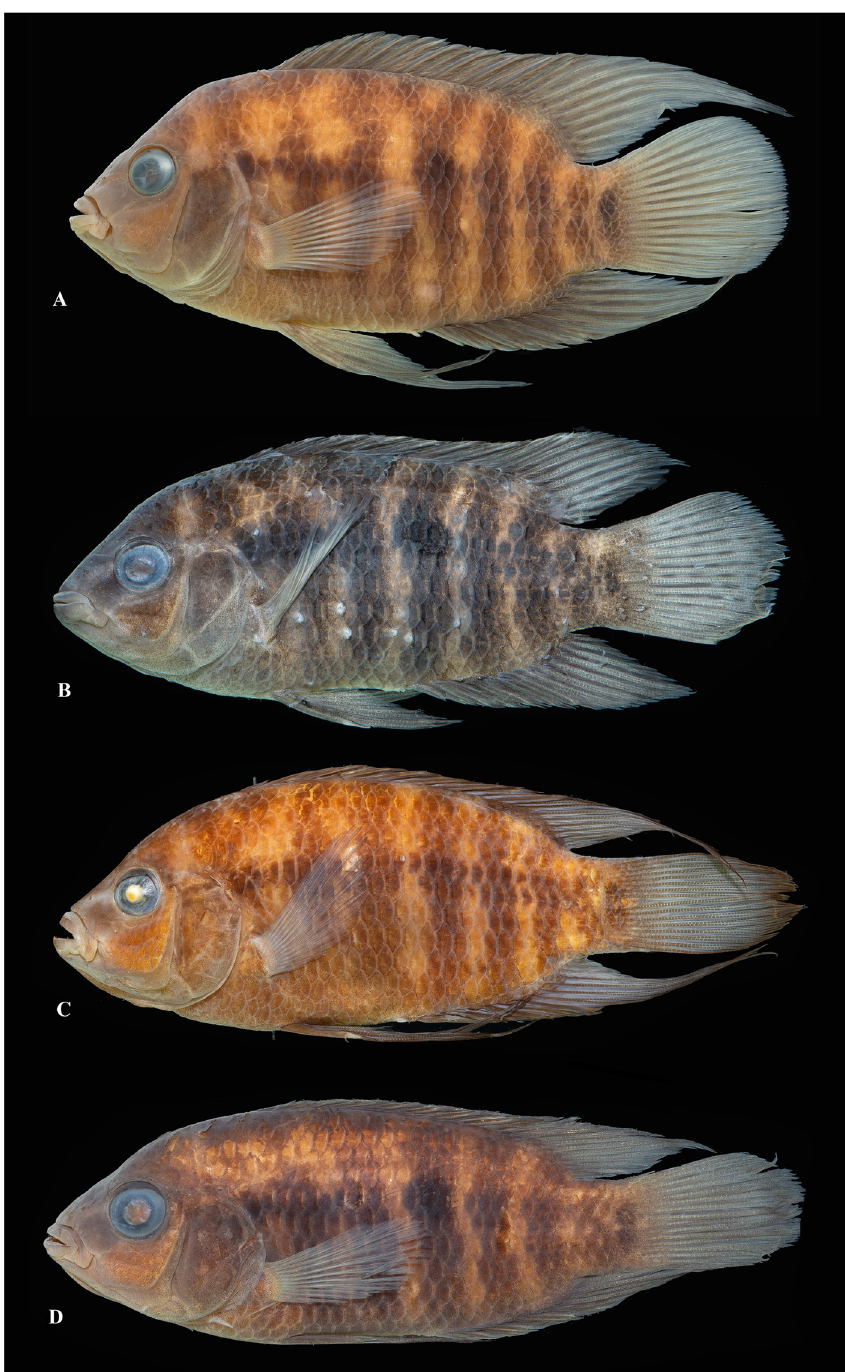
Fig 18. Australoheros oblongus. A. Adult male, 78.6 mm SL; MCP 287195; Brazil: Minas Gerais: Abadia dos Dourados: Rio Grande drainage: Rio Preto on road Palmito–Abadia dos Dourados. B . Adult female, 76.9 mm SL; MCP 49007; Brazil: Minas Gerais: Cardeal Mota: Rio Cipo´ drainage, arroio on road Jaboticatubas to Cardeal Mota. C. Adult male, 84.0 mm SL; LBP 17525; Brazil: Minas Gerais: Bom Jardin de Minas: Rio Paraı´ba do Sul drainage: Cachoeira do Pacau, Ribeir ã o da Bom Jardim de Minas, reversed. D. Adult male, 67.4 mm SL; MCP 31877; Brazil: Minas Gerais: Ouro Preto: upper Rio Doce basin: Lagoa do Manso in Parque Estadual de Itacolomi, reversed.